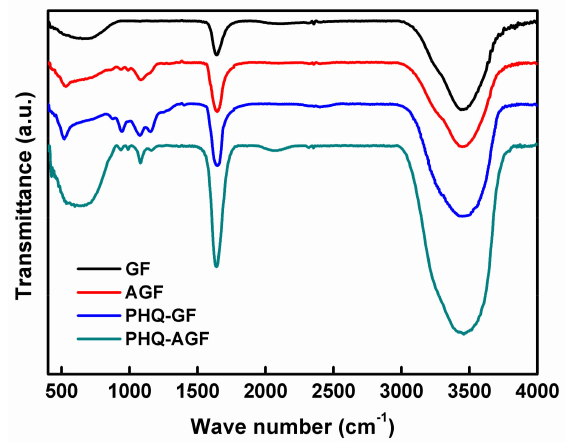
Figure 2. FT-IR spectra of the GF, AGF, PHQ–GF, and PHQ–AGF samples.